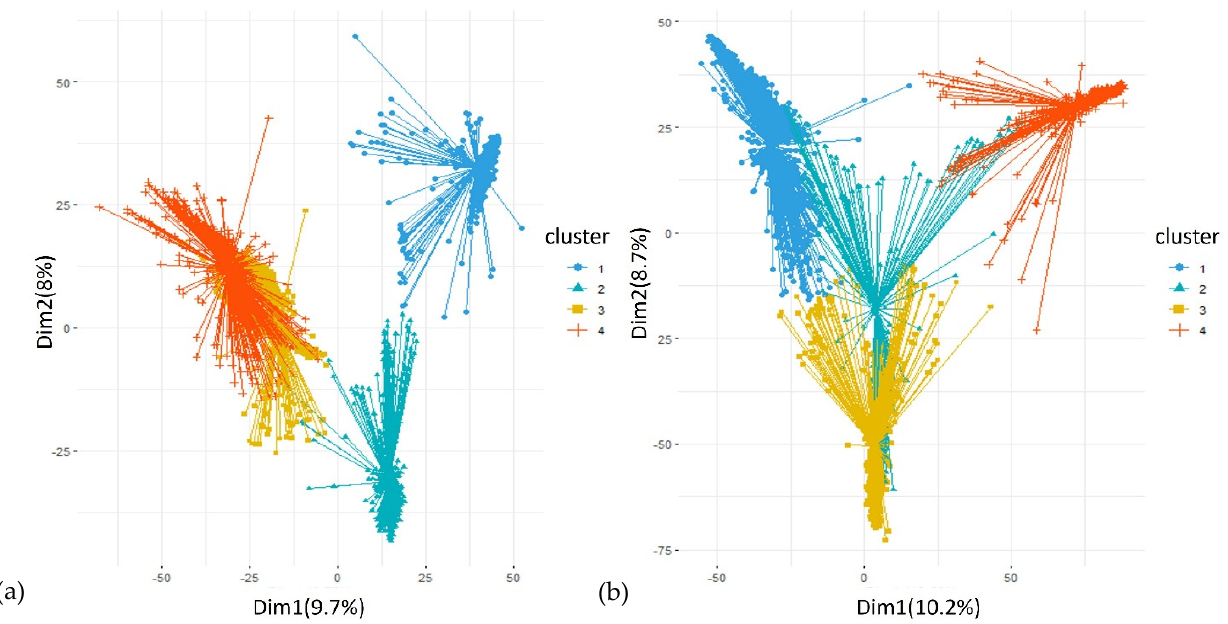
Figure 4. Hierarchical clustering of Sesbania sesban accessions by ( a ) SNP and ( b ) SilicoDArT mark ‐ ers.